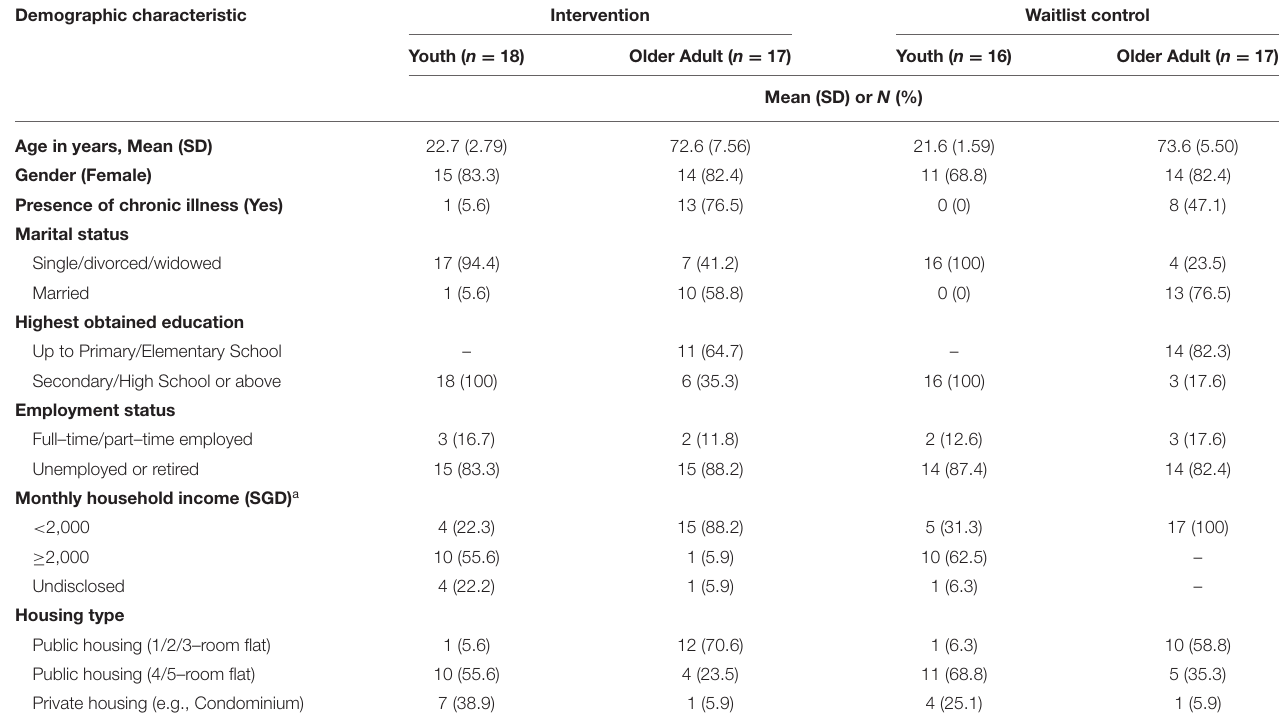
TABLE 2 | Participant demographic information. Demographic